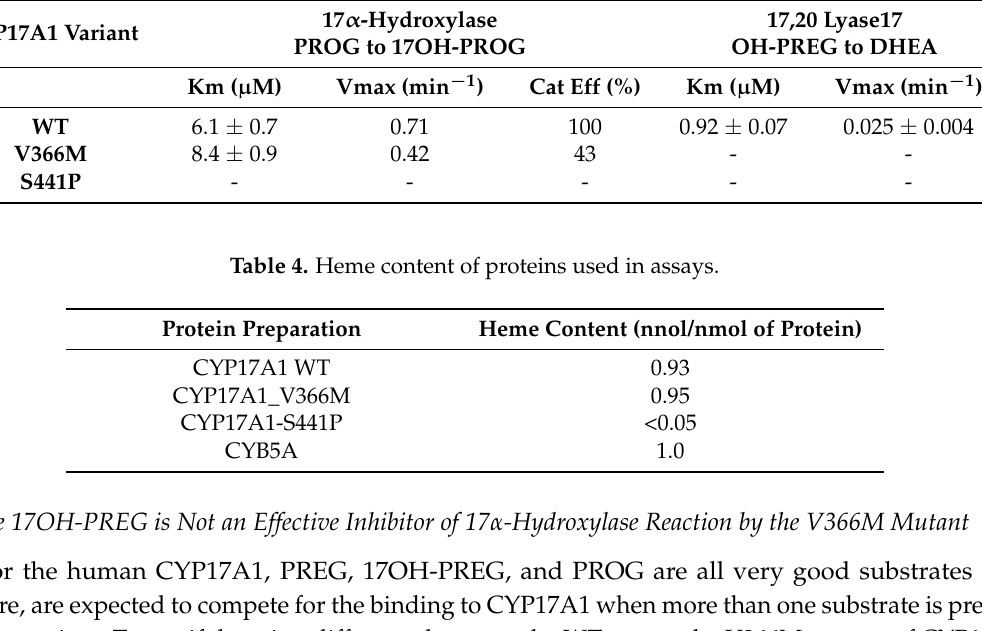
Table 3. Kinetic parameters for the metabolism of PROG to 17OH-PROG (17hydroxylation) and